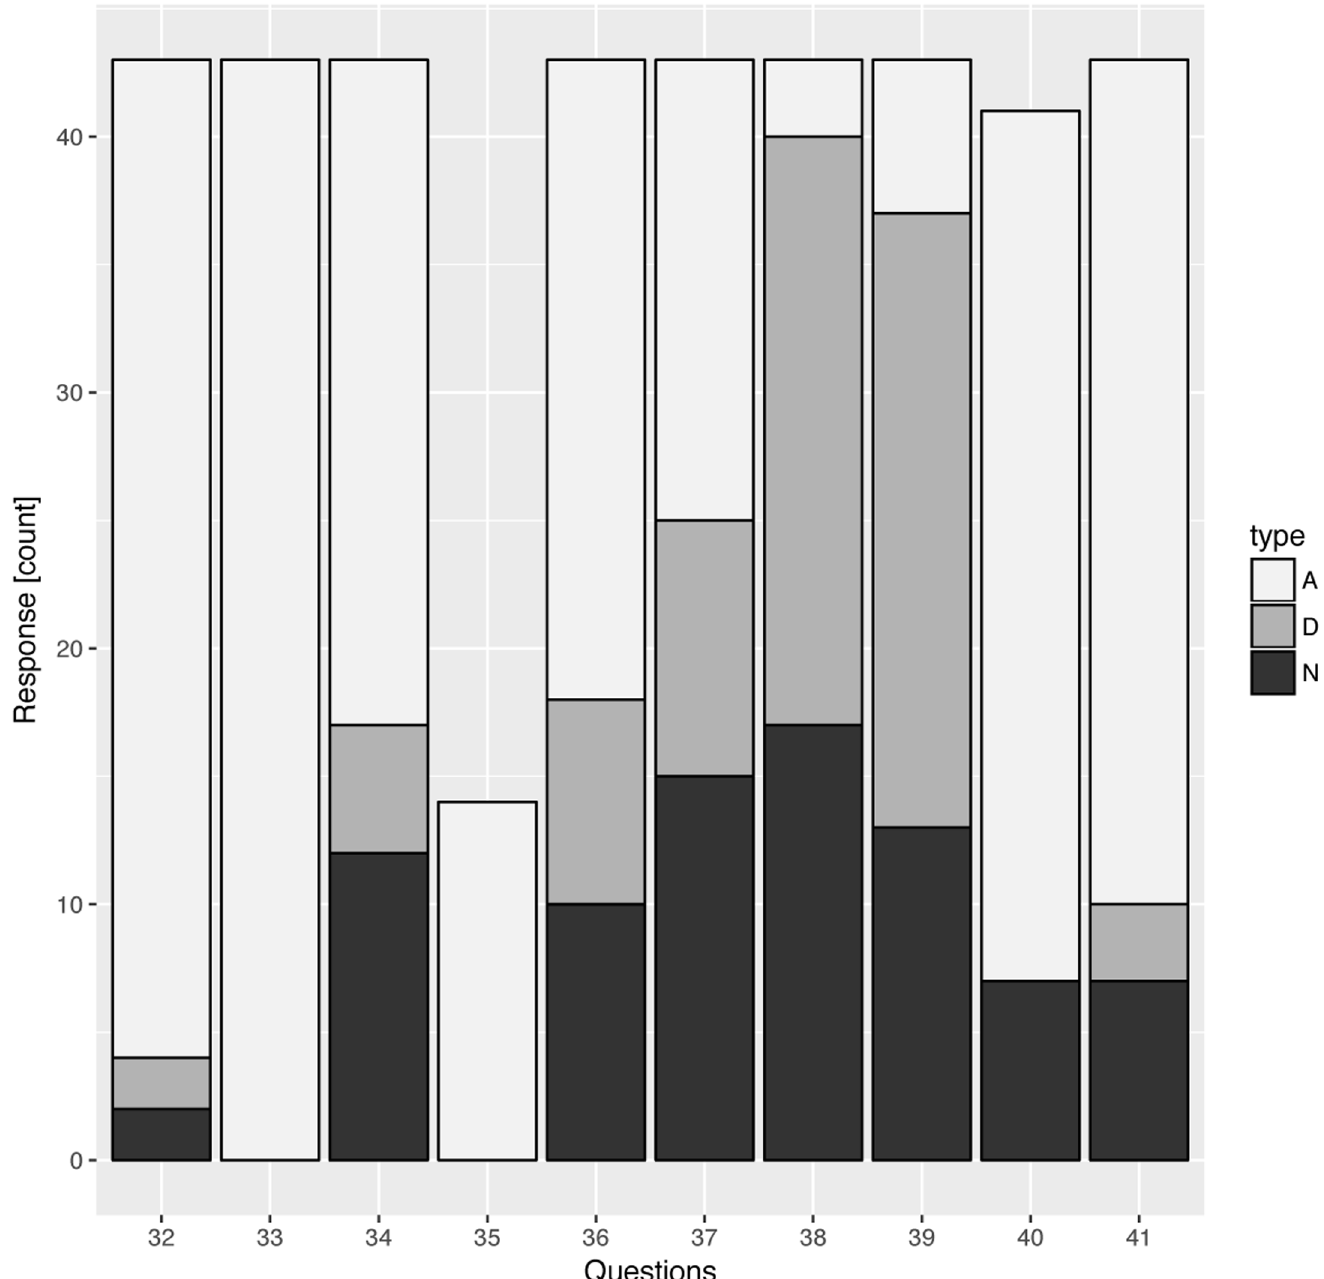
Fig 4. Student perceptions of the usefulness of the bioinformatics module used in this study. Student responses were binnedinto three groups: agree (A), disagree(D), and neutral (N). Student responses were filtered as describedin the Methods. Students had overwhelmingly positive responses to their experience with the module.N (students) = 51. A completelist of the questionscan be found in